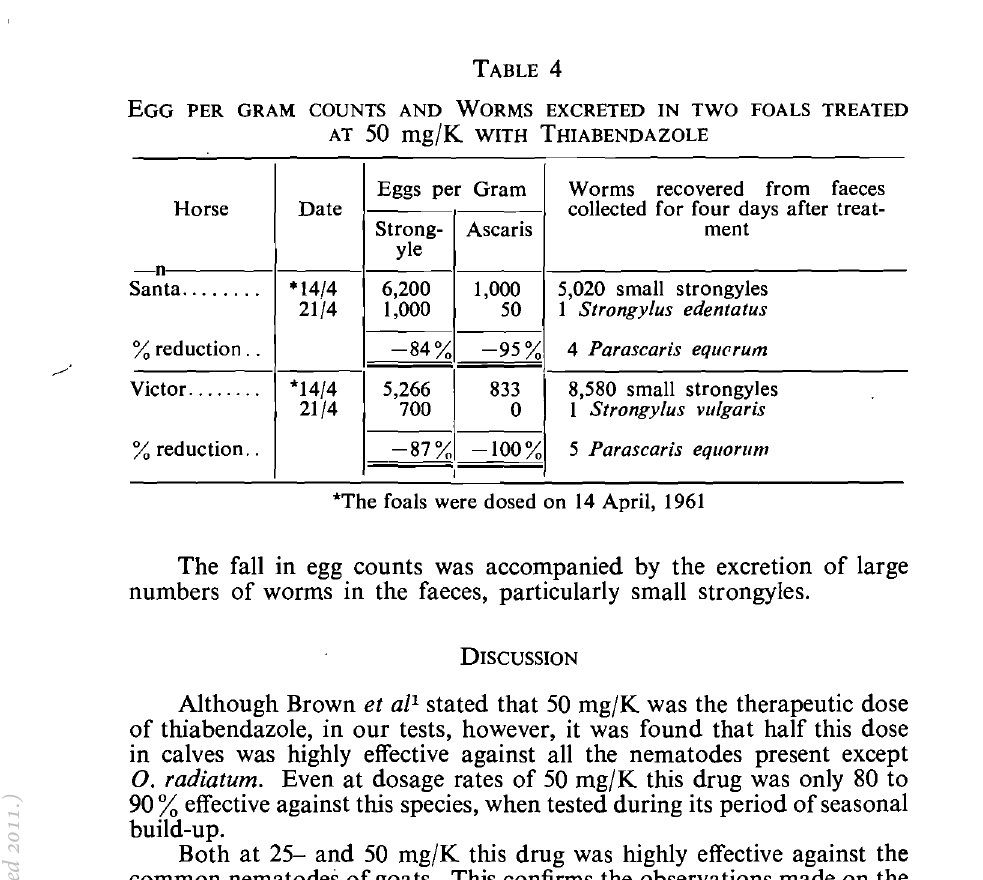
EGG PER GRAM COUNTS AND WORMS EXCRETED IN TWO FOALS TREATED AT 50 mgjK WITH